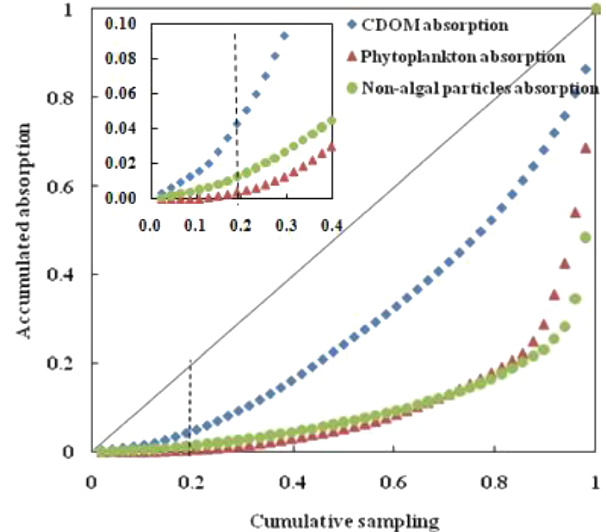
Figure 4. Relative contributions of CDOM, phytoplankton, and non-algal particles to total non-water light absorption at 440nm. Figure 5. Pareto–Lorenz curves derived from the total non-water light absorption at